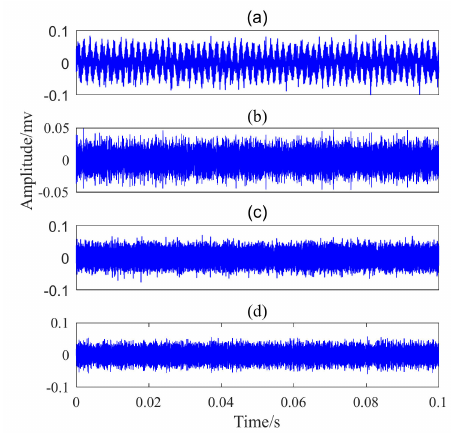
Figure 10. The IMFs of the simulation signal of bearing with outer race fault processed by the Improved EWT method: ( a ) IMF1; ( b ) IMF2; ( c ) IMF3; ( d ) IMF4.